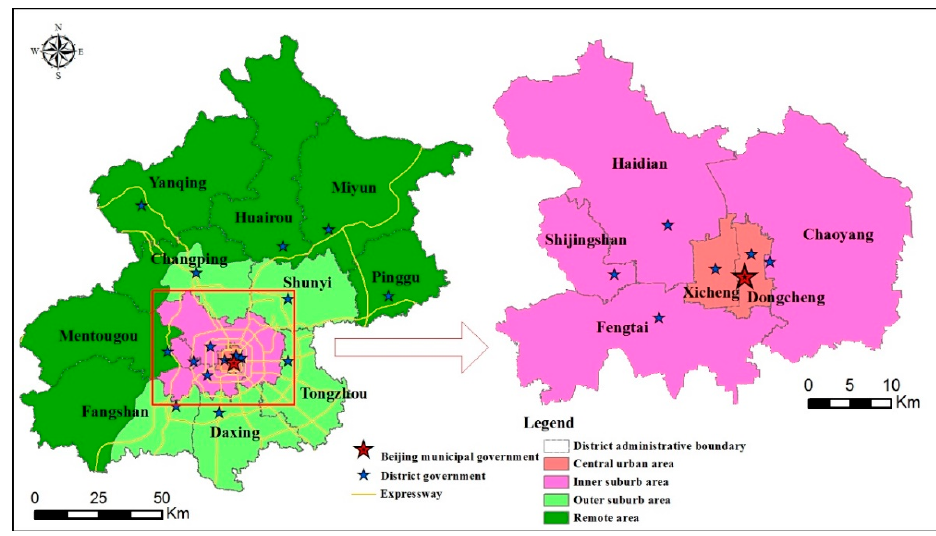
Figure 3. The research area.